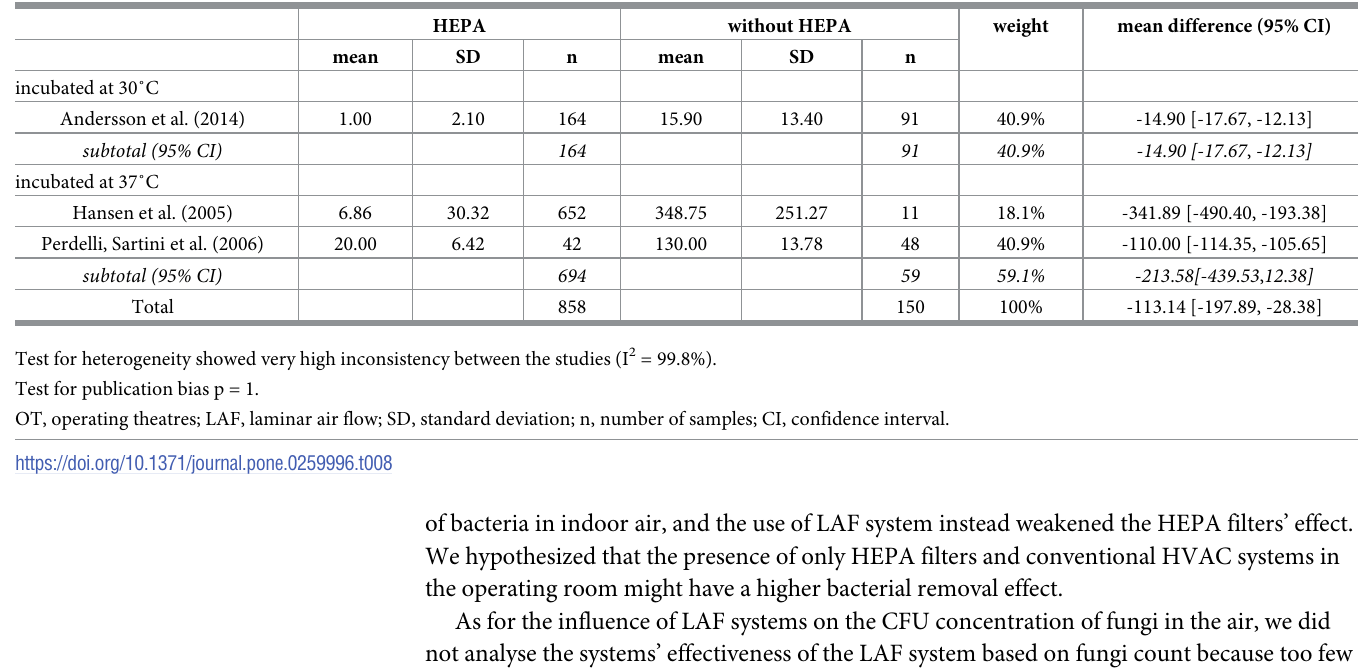
Table 8. Meta-analysis comparing the mean bacterial colony forming units per cubic meter (CFU/m 3 ) in rooms with HEPA vs rooms without HEPA.